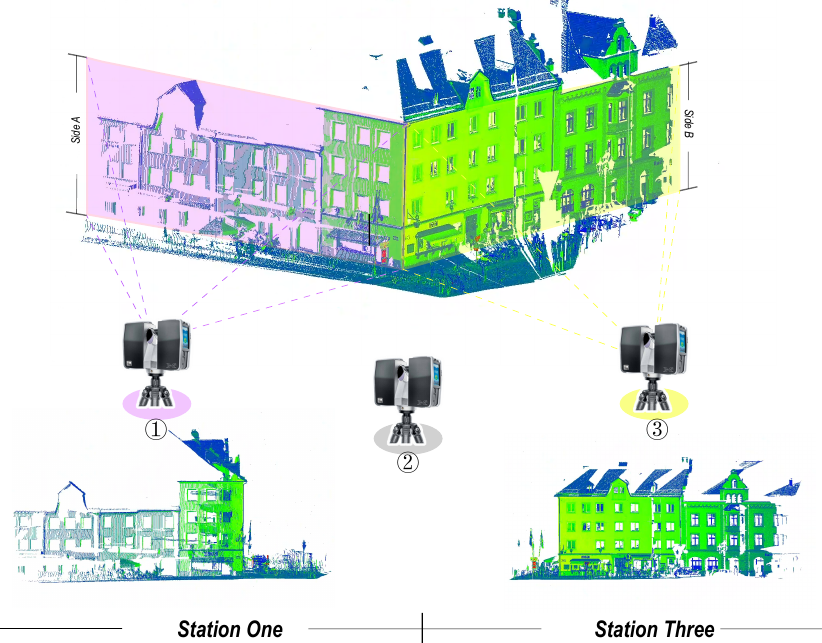
Figure 1. Datasets collected under different perspectives . Lidar systems are deployed at different sites to scan the same building, and datasets collected at each site are different. In general, the farther apart the sites are, the less overlap there is likely to be between the collected